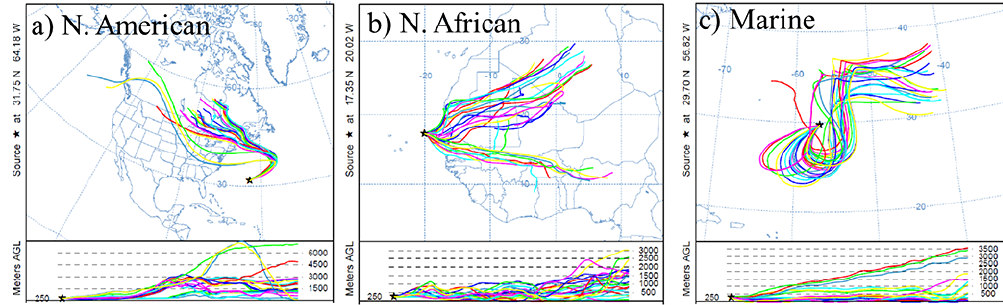
Figure 2. Representative ensemble air mass back trajectories for samples influenced by (a) North American, (b) North African sources, and (c) Marine (minimal recent continental influence).